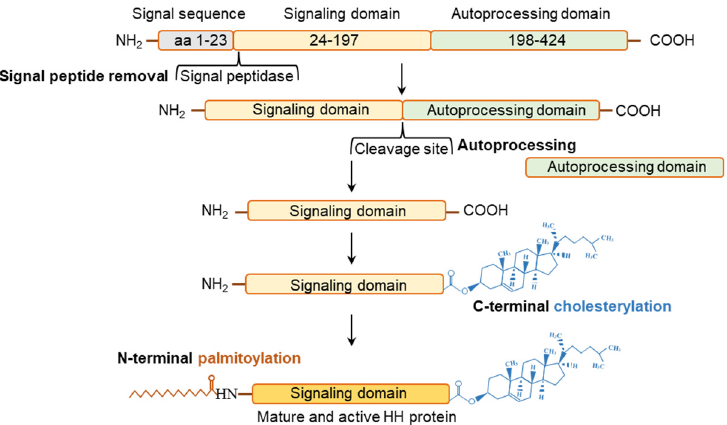
Figure 3. Posttranslational modifications of hedgehog molecules. Posttranslational modification in each of the three HH molecule is similar and highly conserved. The initial HH polypeptide is stepwise cleaved into three domains. After the cleavage of signal sequence (~aa 1-23), the remaining polypeptide is cleaved into a N-terminal signaling domain (~aa 24-197) and a C-terminal autoprocessing domain (~aa 198-424). The Signaling domain undergoes C-terminus cholesterylation and N-terminal palmitoylation before it is secreted in its mature and active form. The autoprocessing domain catalyses the intramolecular chlesterol tranfer reaction necessary for choesterylation of the signaling domain.